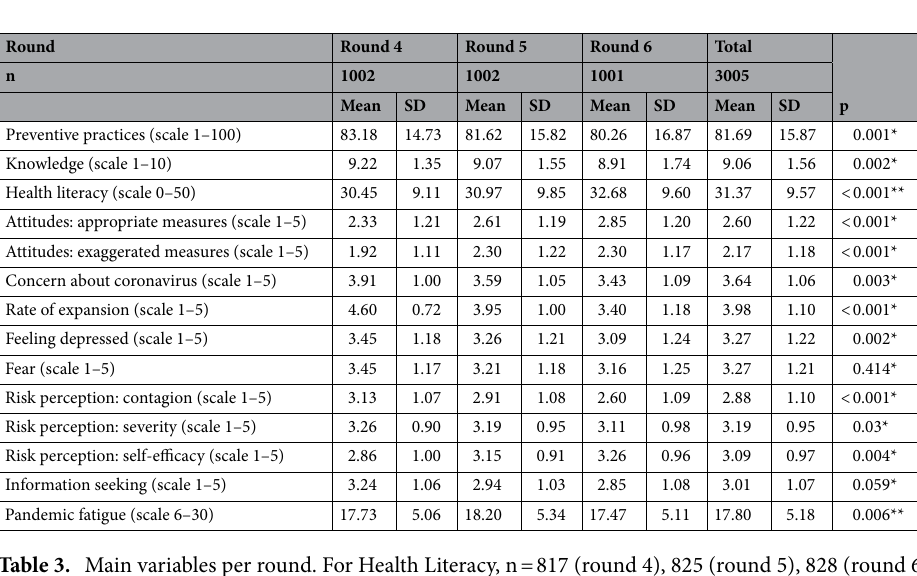
Table 3. Main variables per round. For Health Literacy, n = 817 (round 4), 825 (round 5), 828 (round 6), 2470 (total). *Kruskal Wallis Test. All p-values are two-sided. **ANOVA Test. All p-values are two-sided.